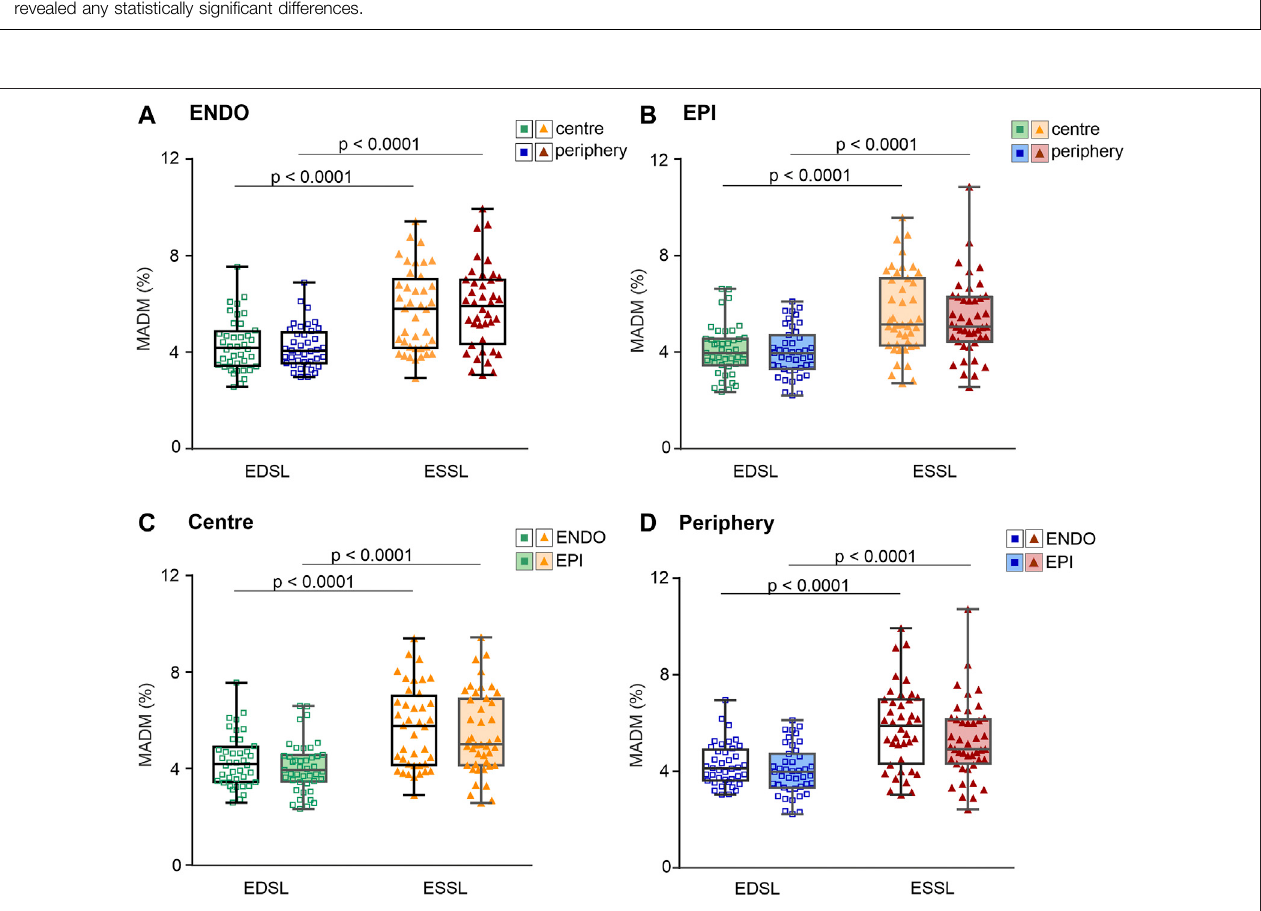
FIGURE 5 | Median absolute deviation divided by median value (MADM, %) obtained for individual SL sets measured at different contraction states (end-diastole, EDSL, or end-systole, ESSL) in central and peripheral intracellular regions of ENDO ( n = 40) and EPI ( n = 43) cardiomyocytes (from 8 hearts). (A) : MADM for SL distributions in ENDO cardiomyocytes. (B) : MADM for SL distributions in EPI cardiomyocytes. (C) : MADM for SL distributions in the central intracellular region of ENDO andEPIcardiomyocytes. (D) :MADMforSLdistributionsintheperipheralintracellularregionofENDOandEPIcardiomyocytes. p < 0.0001,three-wayANOVAwas used for all comparisons. Note that the top and bottom panels contain the same data sets, but displayed in different compositions depending on the comparison factor (top panels = ENDO vs . EPI, bottom panels = centre vs . periphery).